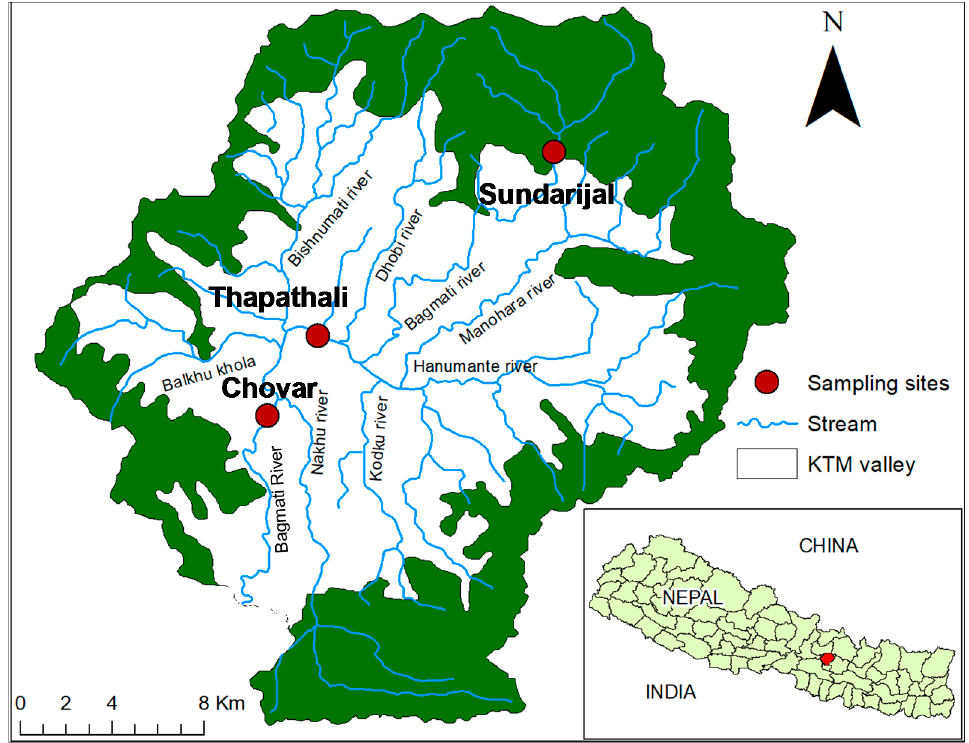
Figure 1. Map of the Kathmandu Valley showing three sampling sites.